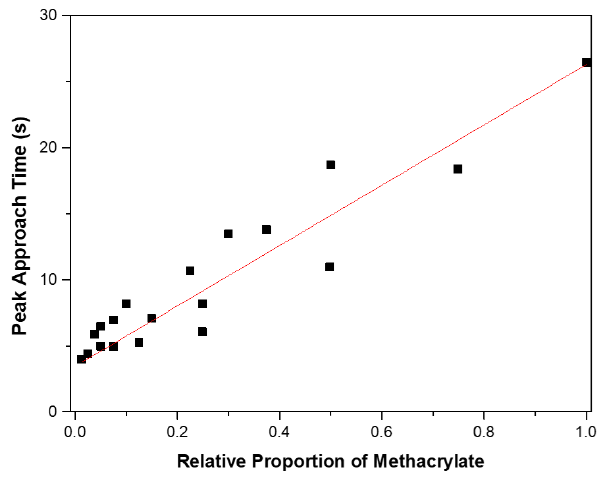
Figure 6. Change in peak approach time with changes in relative proportion of methacrylate ( R 2 = 0.966).